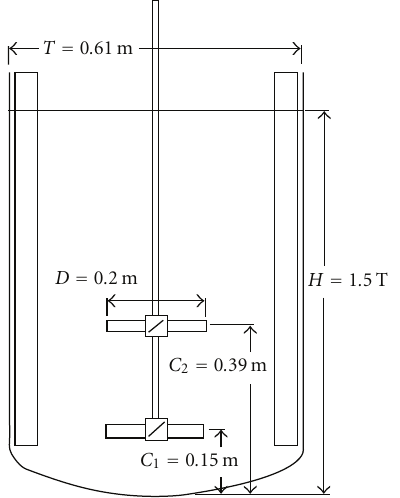
Figure 1: Schematic representation of the stirred tank reactor.